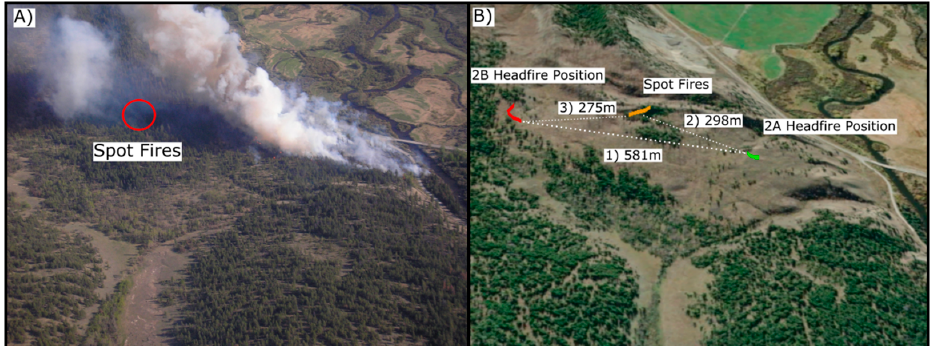
Figure 10. ( A ) Spot fires identified (red circle) on the Site 2 image at 18:16; ( B ) the headfire position at image 2A (green line), image 2B (red line) and the spot fire position (orange line); spread distances (1,3) and minimum spotting distance (2) are as indicated.